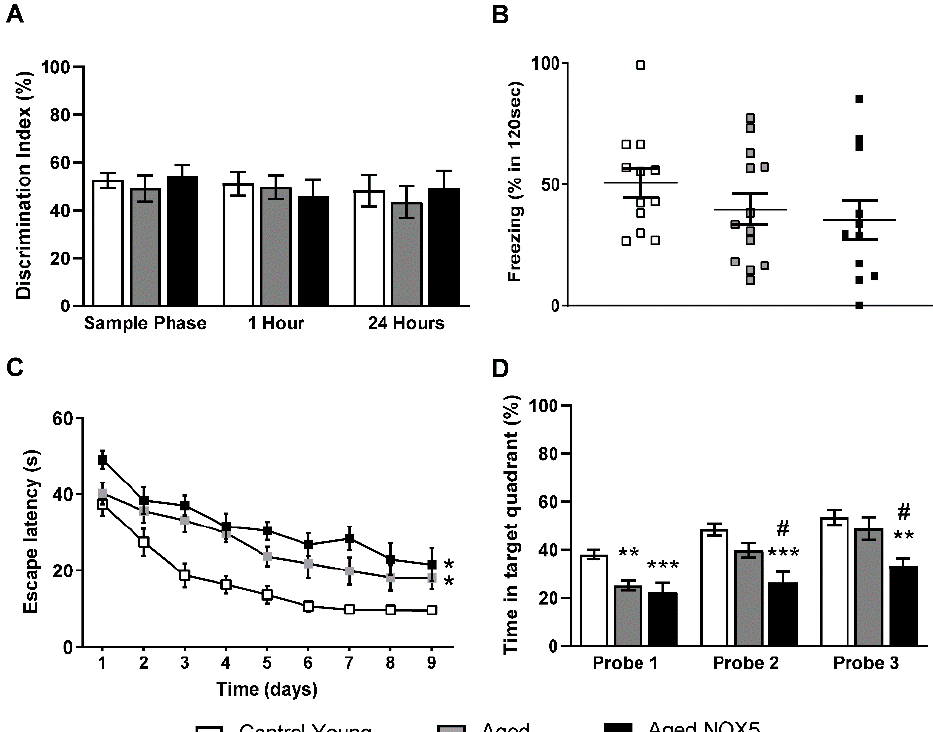
Figure 5. Behavioral tests. ( A ) The Novel Object Recognition Task (NORT) results expressed as the percentage of time spent exploring the new object with respect to the total exploration time (discrimination index). ( B ) The fear conditioning test results expressed as the percentage of time that the mice froze in 120 seconds after the exposition to a new object. ( C ) The Morris water maze (MWM) acquisition phase results are expressed as the time taken to reach the platform (the escape latency) in seconds. * p < 0.05 vs . Control Young . ( D ) The MWM retention phase results are expressed as the percentage of time spent in the quadrant where the platform was previously located. ** p < 0.01, *** p < 0.001 vs . Control Young and # p < 0.05 vs . Aged . n = 12–14. The results are expressed as the mean ± SEM. Control Young : young mice, Aged : CRE +/ − aging mice and Aged NOX5 : NOX5 +/ − CRE +/ − aging mice.